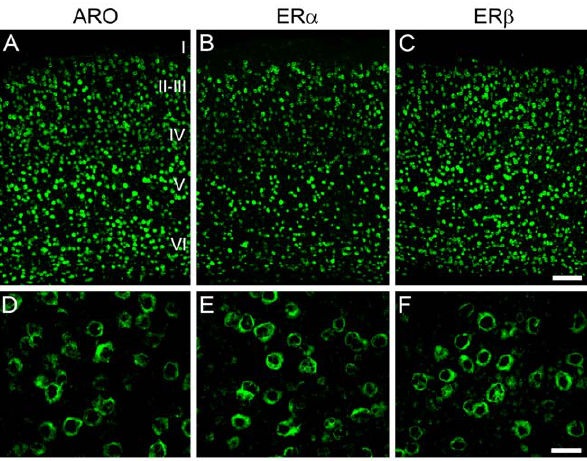
Figure 1. The primary visual cortex (V1) contains a large population of estrogen-producing and estrogen-producing neurons. A–C) Low-power photomicrographs depicting fluorescence in-situ hybridization directed against the mRNAs encoded by ARO (A), ER a (D) and ER b (C) in V1. Each of these mRNAs is expressed at relatively high levels in all cortical laminae, except for layer I. D–F)